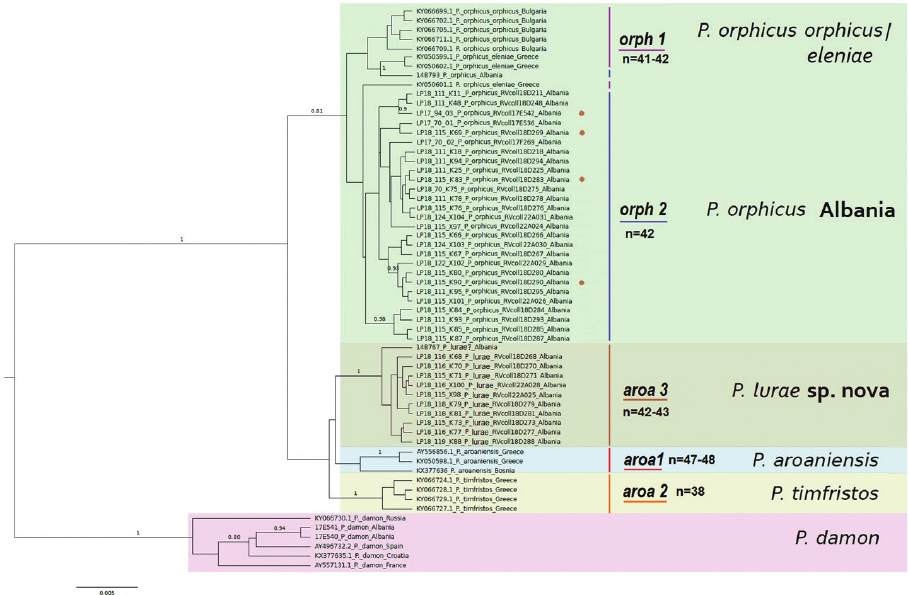
Figure 2. Bayesian inference tree based on 658-bp of the gene COI for the entire Polyommatus aroaniensis species complex. Node posterior probabilities (0.80 and higher) are written on the branches. The scale bar indicates the length of 0.005 substitutions/site. Main clades are highlighted and COI haplogroups and karyotype numbers indicated: P. orphicus orphicus/eleniae ( orph1 , n=41–42), P. orphicus Albania ( orph2 , n =42), P. aroaniensis ( aroa1 , n=47–48), P. timfristos ( aroa2 , n=38) and P. lurae sp. nov ( aroa3 , n=42–43). Brown dots next to specimens within the orph2 clade indicate P. lurae × P. orphicus potential hybrids (n=43–44) found in the contact zone or